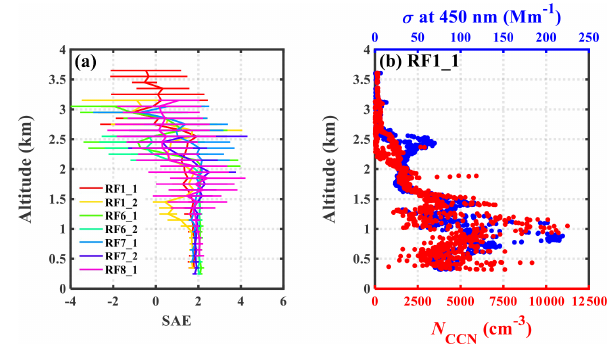
Figure 6. Vertical distributions of (a) aerosol scattering Ångström exponent (SAE) during the vertical spiral flights (error bars are stan- dard deviations of SAE) and (b) N CCN at 0.7%SS (red dots) and aerosol scattering coefficient ( σ ) at 450nm (blue dots) during the RF1_1 vertical spiral flight.